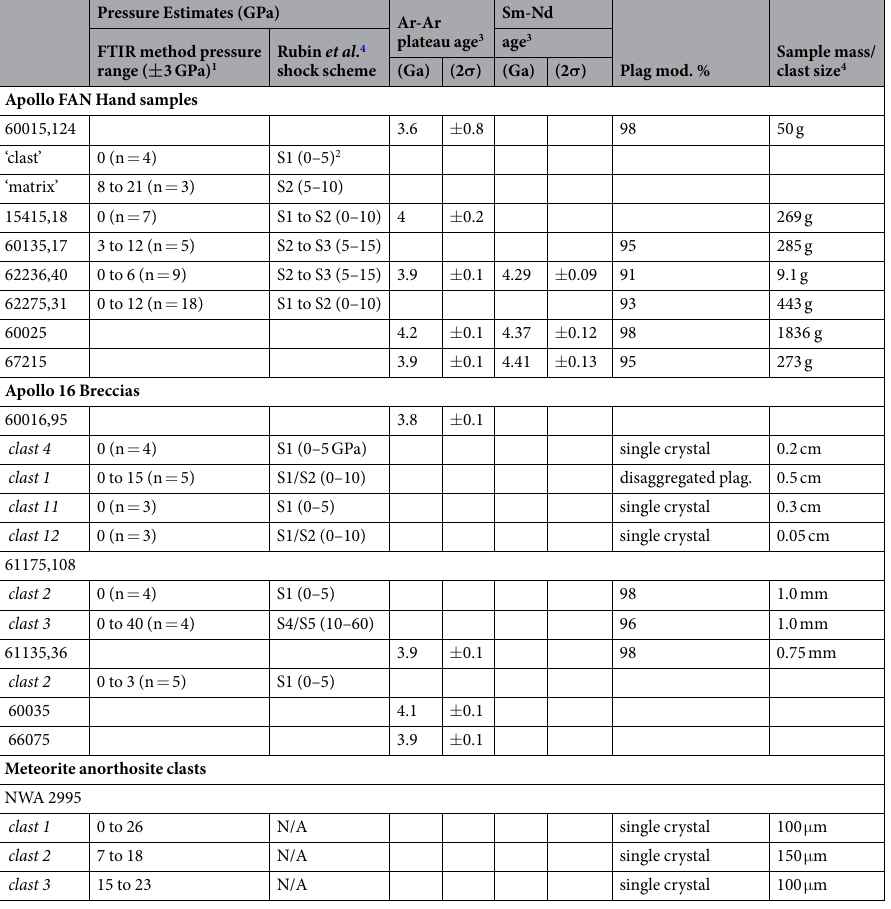
Table 2. Estimated shock pressures for highland samples in addition to clast size and plagioclase mod. %. 1 All FTIR derived pressures have ± 3 GPa uncertainties (1 σ ) – see SOM methods. 2 See Table S3 for summary of